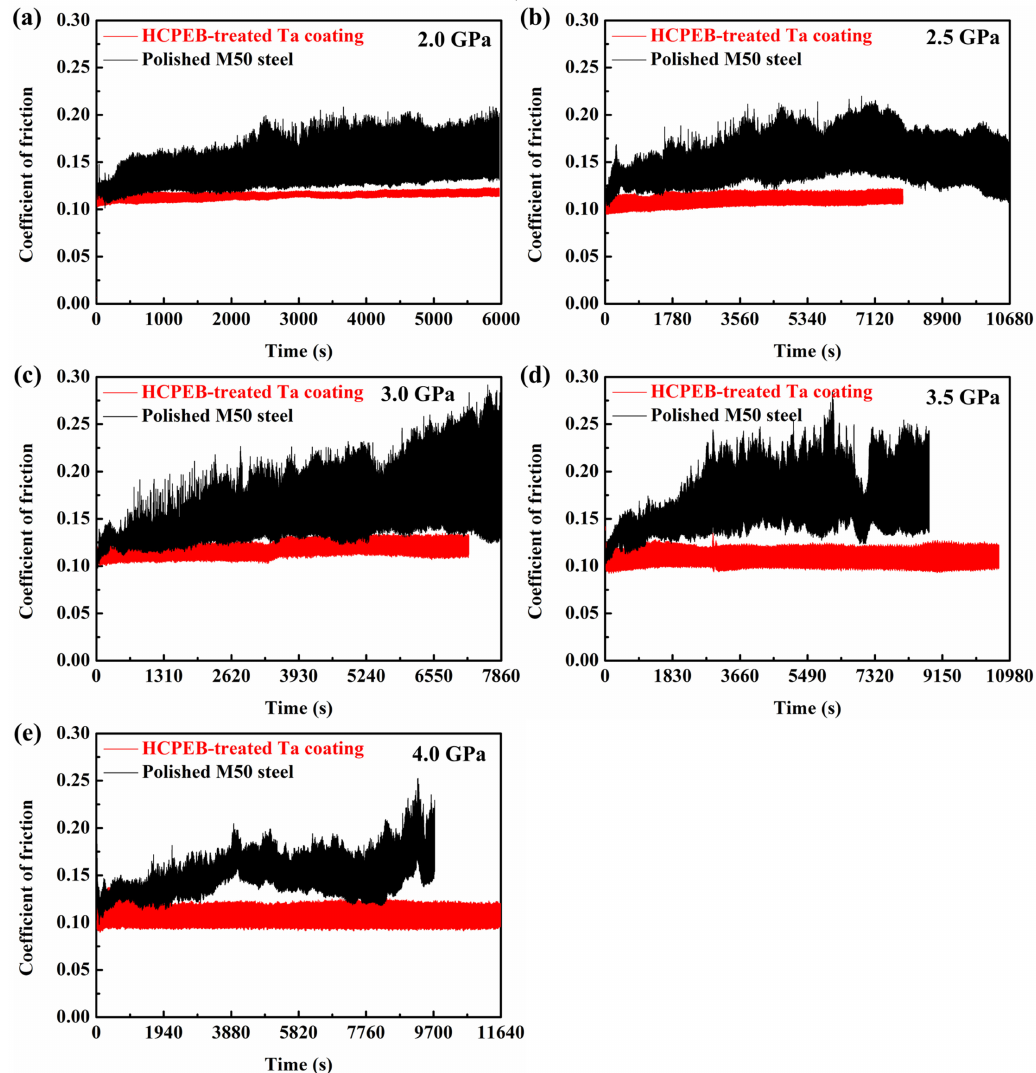
Figure 5. Coefficients of friction (COFs) of bare (polished) M50 steel and HCPEB-treated Ta coating as a function of time while sliding in pure JP-10 against a Si 3 N 4 ball at room temperature in ambient atmosphere: ( a – e ) 2.0–4.0 GPa,